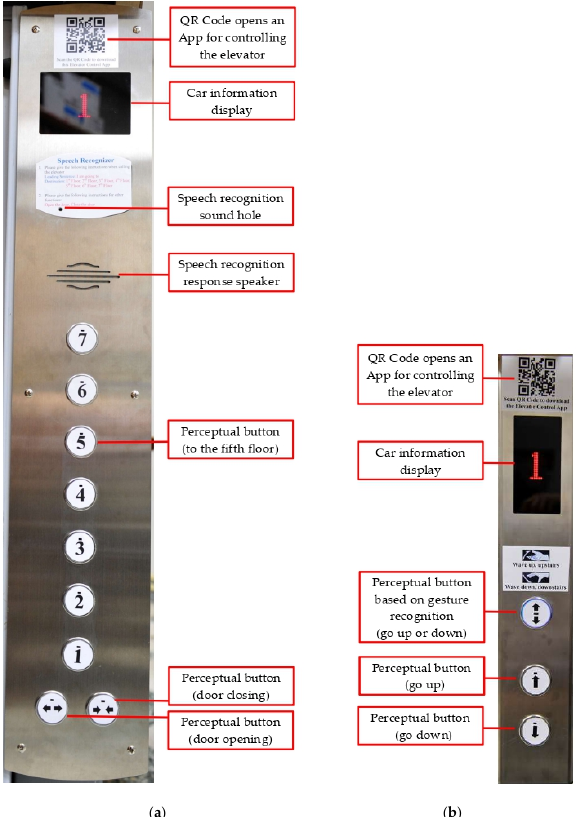
Figure 15. Elevator consoles. ( a ) Console in the elevator car; ( b ) console on the wall of elevator hall.